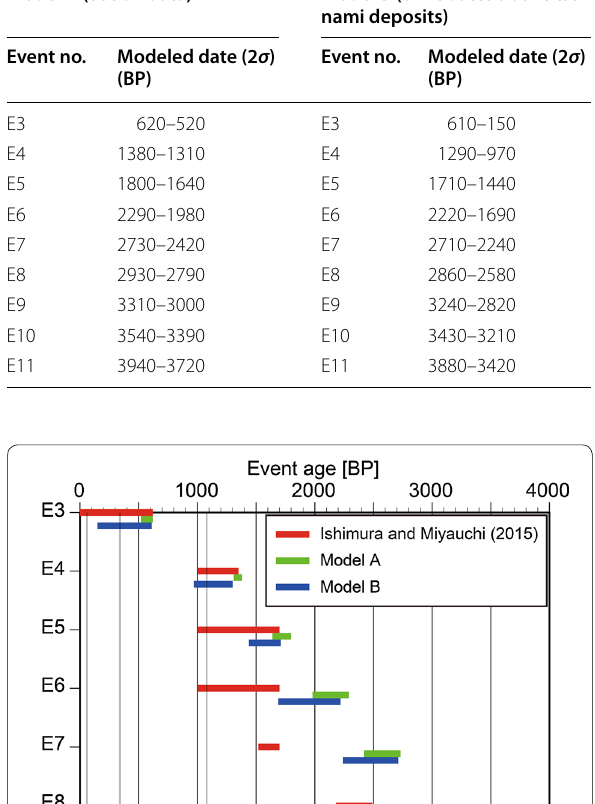
Table 3 Modeled dates of tsunami deposits Model A (use all data)